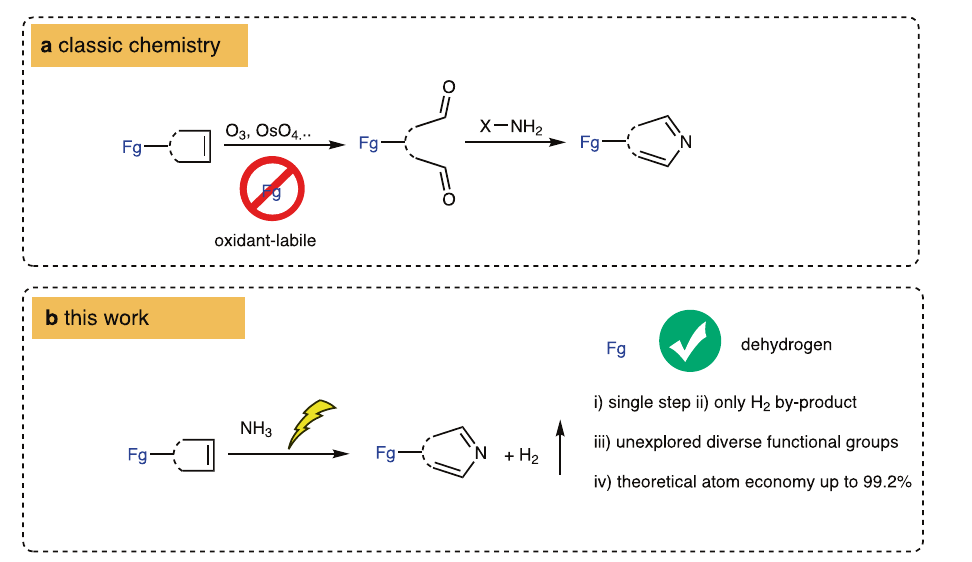
Fig. 1 Comparison of protocols to construct aromatic N -heterocycles from alkenes. a Classic chemistry, oxidation/condensation. b This work, dehydrogenative insertion of NH 3 . Fg = functional groups.